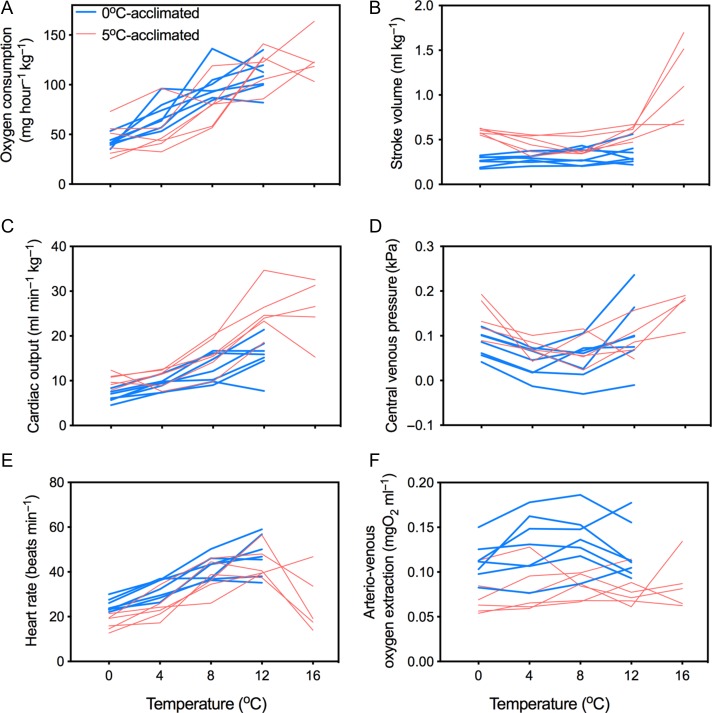
Individual data curves demonstrating the effects of 0°C (blue lines) and 5°C acclimation (6–9.5 weeks, red lines) on oxygen consumption (A), stroke volume (B), cardiac output (C), central venous pressure (D), heart rate (E) and arterio-venous oxygen extraction (F) during an acute thermal challenge